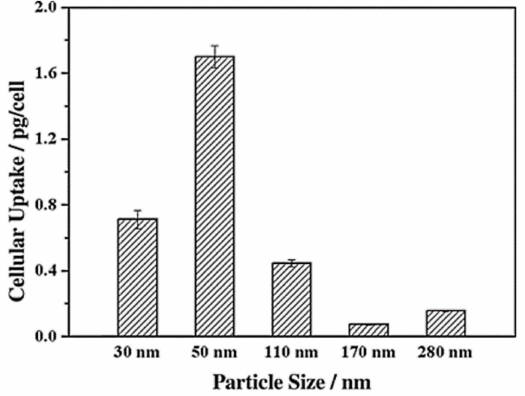
Figure 8. Cellular uptake of FITC-MSN-x based on nanoparticle size. Reproduced with permission from [103], WILEY-VCH Verlag GmbH and Co. KGaA,